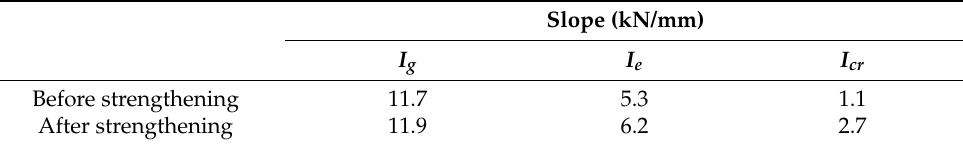
Table 3. Comparison of